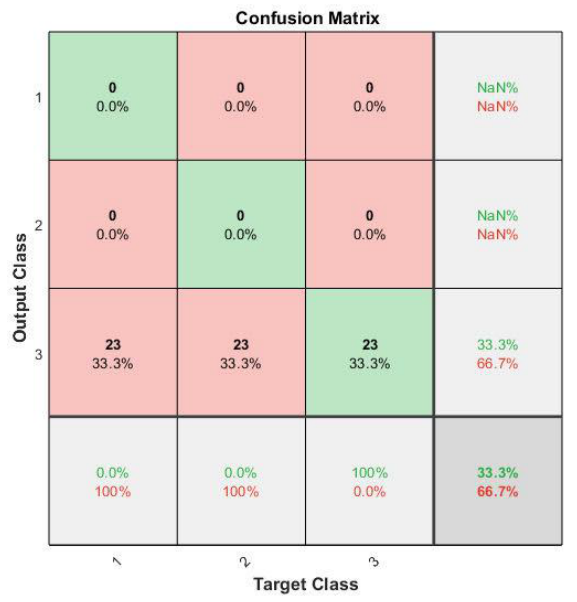
Figure 8. Training results with raw data in the form of a confusion matrix.